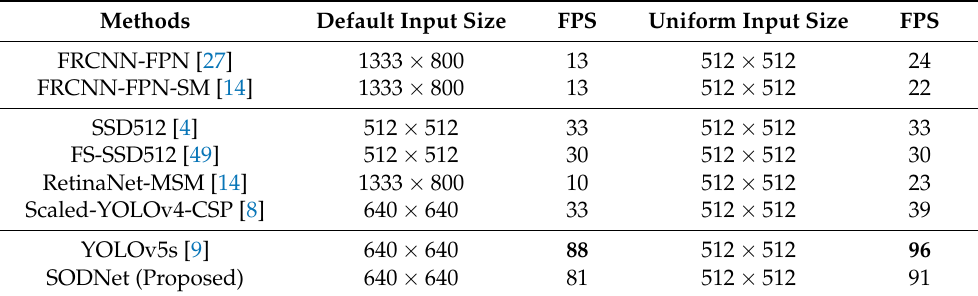
Table 7. TinyPerson test dataset was performed on a Nvidia Tesla P100 for testing, where the Batch size and IoU thresholds were set to 1 and 0.5, respectively. The best results are marked in